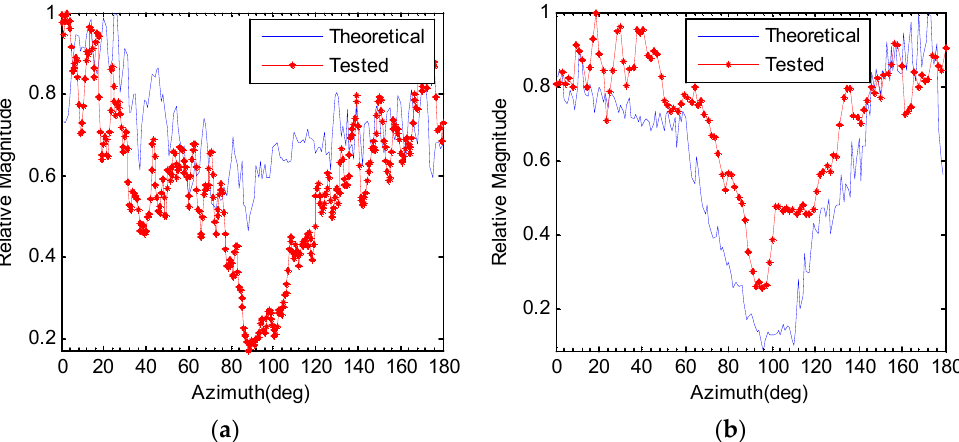
Figure 8. Theoretical and tested echo envelope fluctuation intensity with the frequency of LFM 20–40 kHz. ( a ) The pulse length is 1 ms; ( b ) the pulse length is 3 ms.